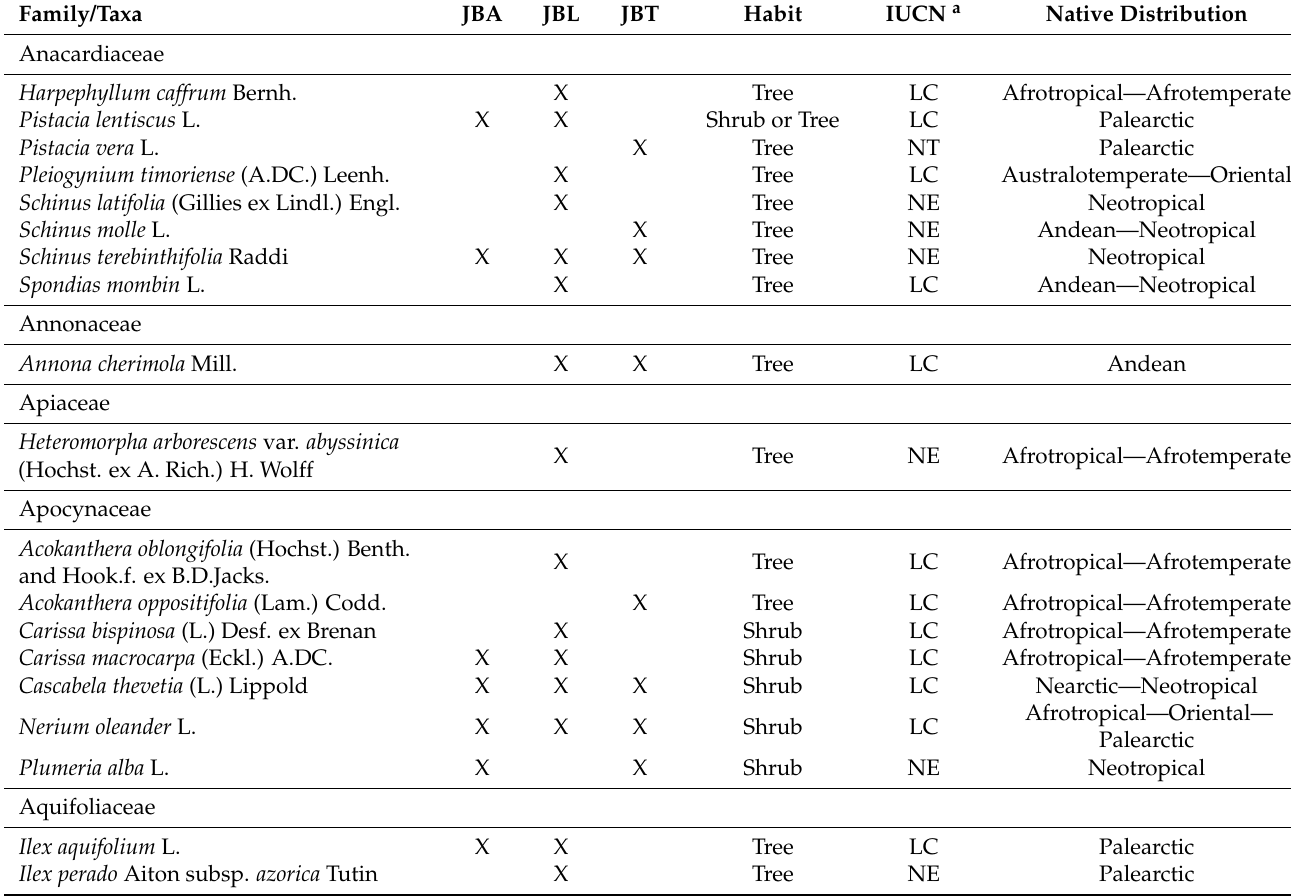
X X Shrub or Tree LC Palearctic X Tree NT Palearctic X Tree LC Australotemperate—Oriental X Tree NE